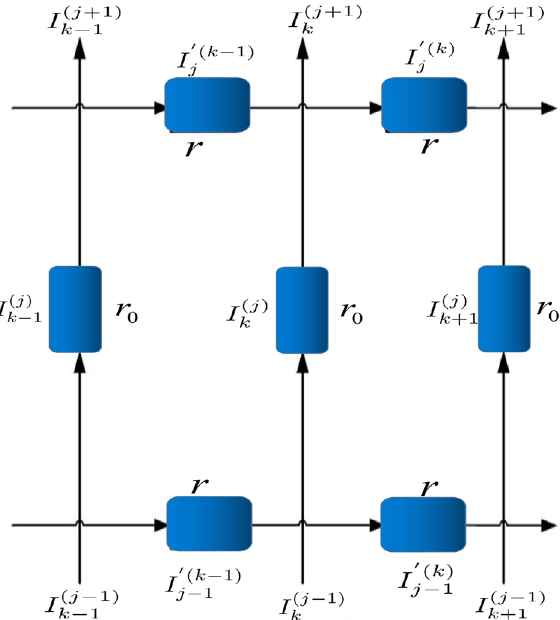
Figure 1. An m n globe network which has n longitude and m × and latitude directions are r 0 and r , respectively.